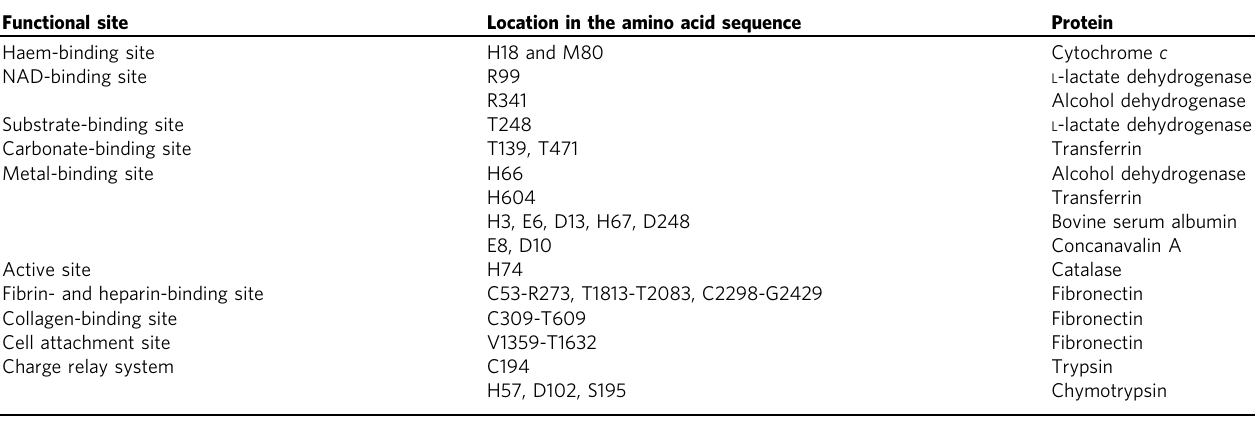
The location of the functional sites is based on UniProt database 28